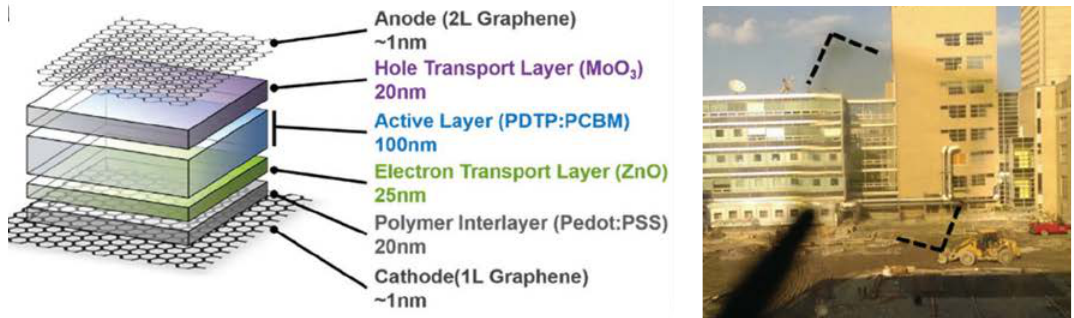
Figure 3. Axonometric view of the device structure; Photograph taken through a device, with dotted lines outlining device corners. Reproduced from [37], with permission from John Wiley & Sons Inc. (2016).